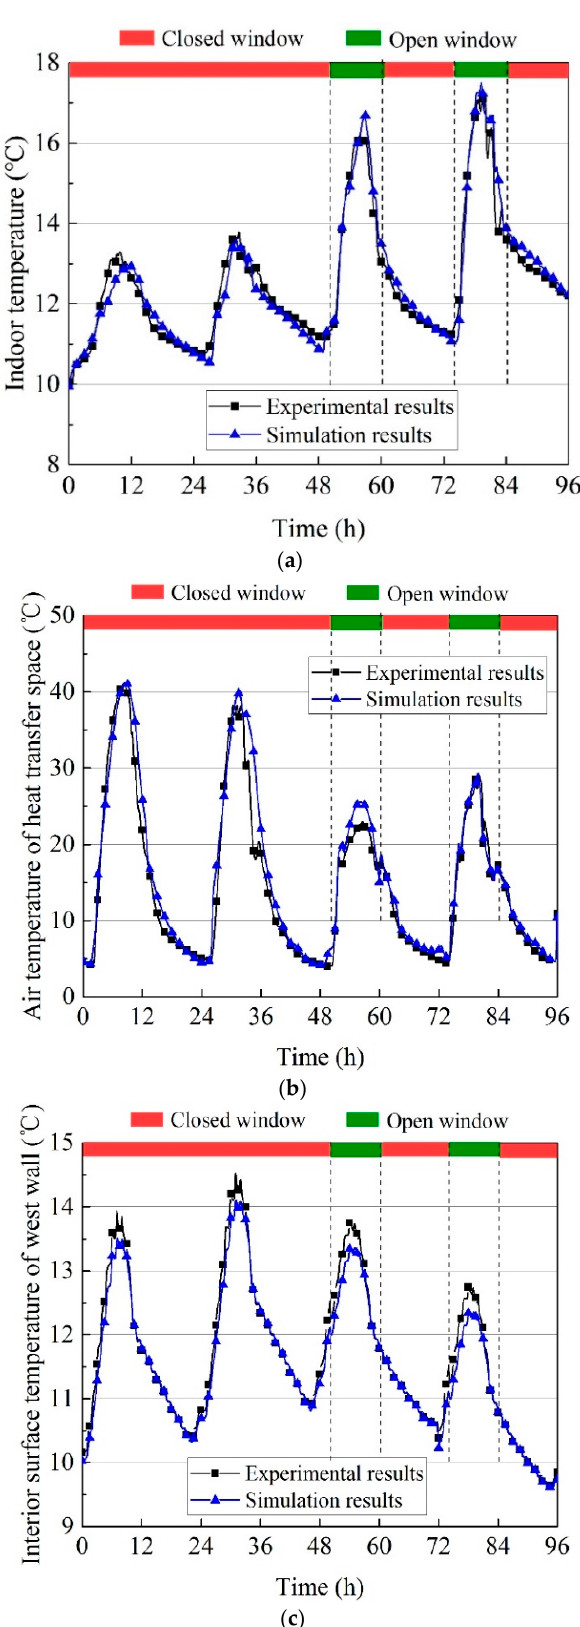
Figure 9. Comparison of Results from experiments and simulations. ( a ) Indoor air temperature; ( b ) Air temperature of heat transfer space; ( c ) Interior surface temperature of west wall.